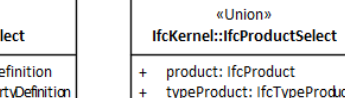
Figure 6. UML class diagram showing examples of IFC enumerations.